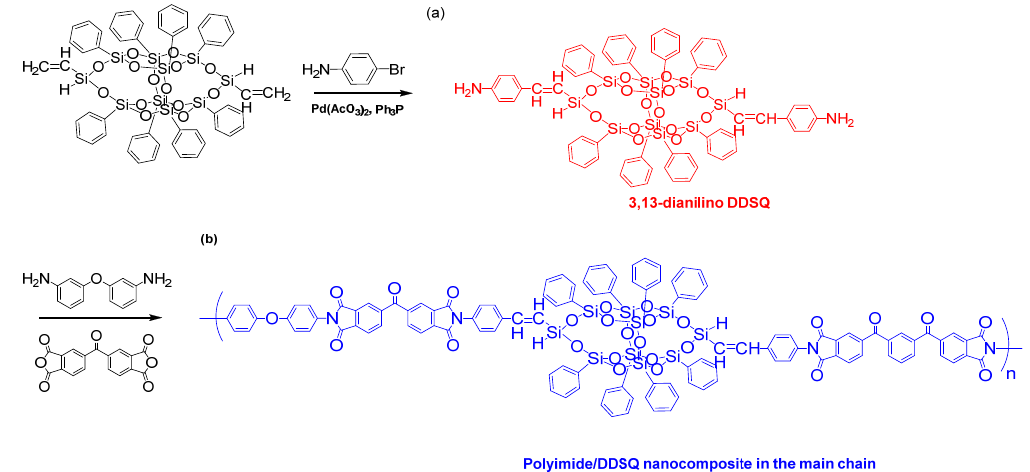
Figure 12. Preparation of organic/inorganic PIs with DDSQ in the main chain [82]. Reproduced with permission from the Royal Society of Chemistry.